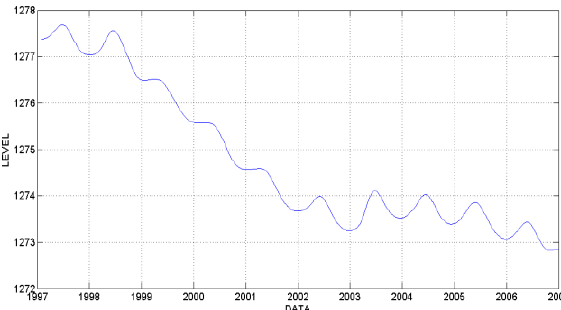
Fig. 11: correlation plot between the precipitation and the